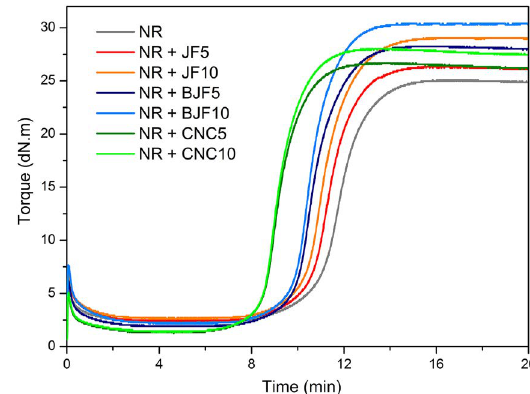
Figure 4. Rheometric curves for the three NR composites containing raw jute fibers (JF), bleached jute fibers (BJF), and